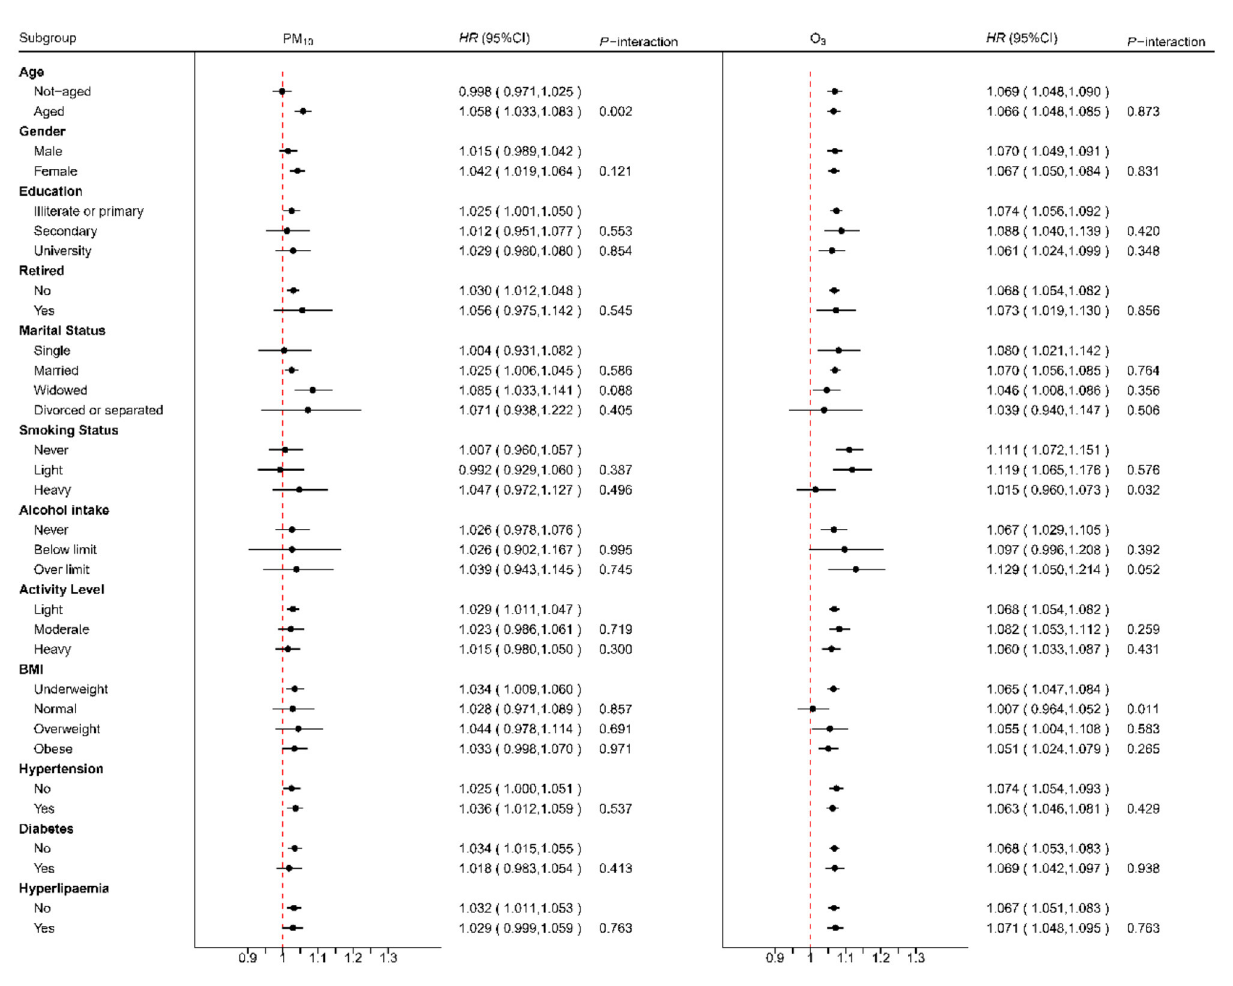
FIGURE1 The modification effect on the association between air pollution (O 3 and PM 10 ) and all-cause hospitalization by different individual factors.